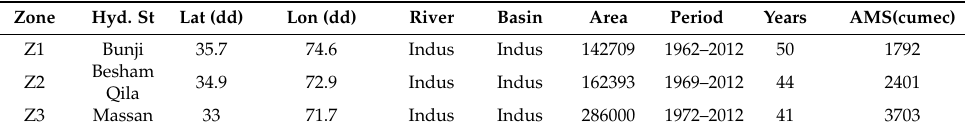
Table 1. Hydrometric stations in UIB.